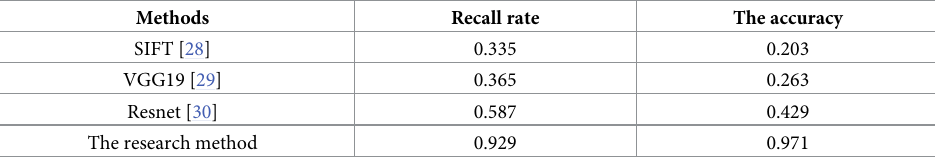
Table 7. Comparison of commodity recognition performance of different